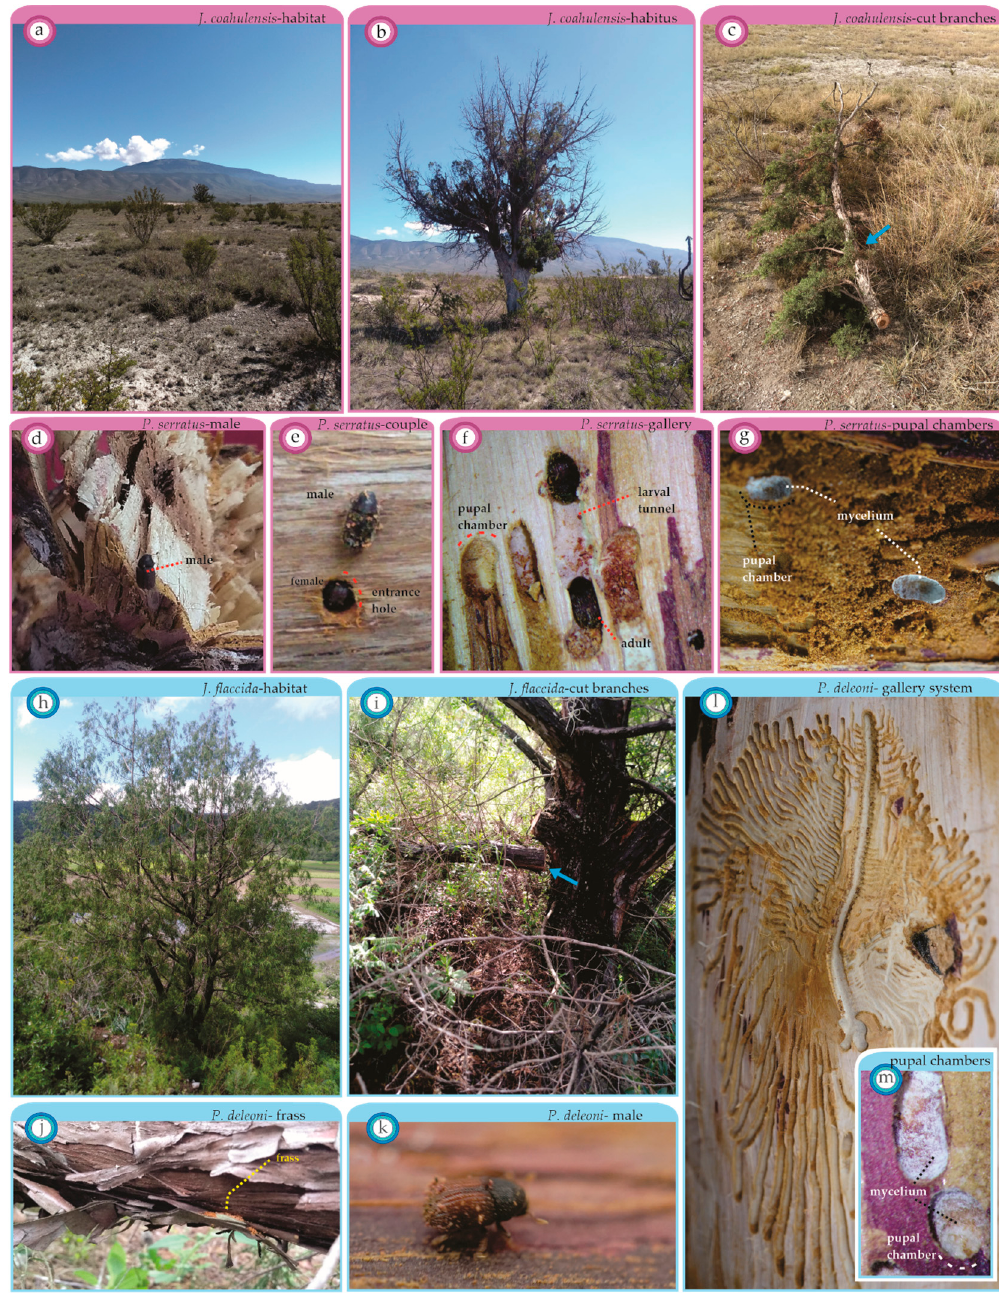
Figure 2. A sampling of the Juniperus hosts and Phloeosinus vector species studied. Pink and blue squares correspond to samples from Galeana ( a – g ) and Iturbide ( h – m ) municipalities, respectively, Nuevo Leon, Mexico. ( a ) Semi-arid xerophytic scrub landscape; ( b ) habitus of Juniperus coahuilensis; ( c ) cut branch of J . coahuilensis used as a lure; ( d ) male of Phloeosinus serratus on bark; ( e ) male and female of P . serratus in entrance hole; ( f , g ) larval galleries and pupal chambers of P. serratus with mycelium of strains from Geosmithia langdonii-Geosmithia sp. 32 clade; ( h ) habitus of J. flaccida in semi-arid forest; ( i ) cut branch of J . flaccida used as a lure; ( j ) frass as a sign of bark beetles colonizing; ( k ) male of P. deleoni on bark; ( l , m ) the gallery system and pupal chamber of P . deleoni with a signal of growth of mycelium of strains from Geosmithia sp . 21.- G. xerotolerans clade .